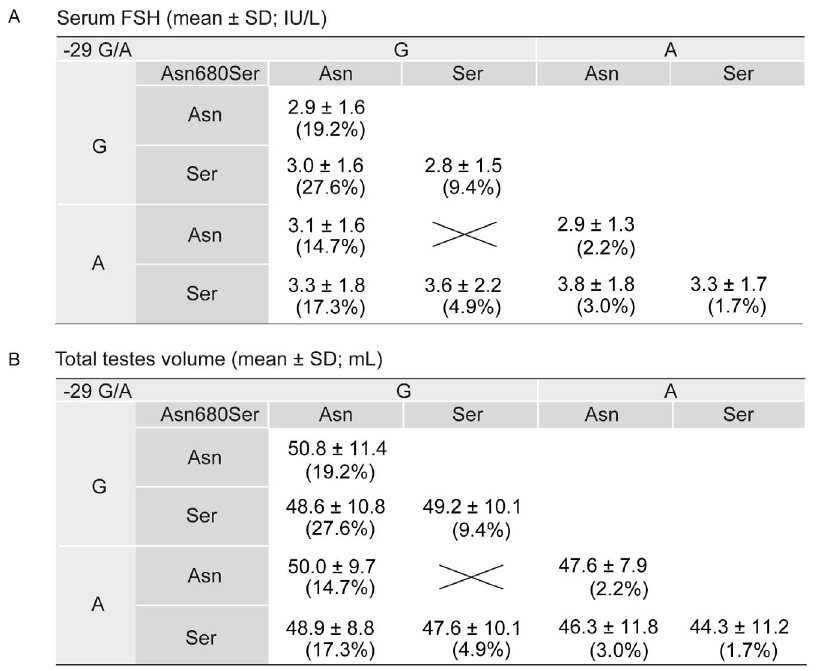
Figure 2. Effect of the carrier status of FSHR -29G/A and Asn680Ser genotype combinations on reproductive parameters. Effect of the FSHR -29G/A (rs1394205) and FSHR Asn680Ser (c.2039A . G, rs6166) genotype combinations on ( A ) serum FSH level (IU/L; mean 6 SD) and ( B ) total testes volume (mL; mean 6 SD) among the Baltic male cohort sample (n=982). The -29G/A and Asn680Ser variants form nine possible FSHR genotype combinations: GG-AsnSer (n=271), GG-AsnAsn (n=189), AG-AsnSer (n=170), AG-AsnAsn (n=144), GG-SerSer (n=92), AG-SerSer (n=48), AA-AsnSer (n=29), AA-AsnAsn (n=22), AA-SerSer (n=17). The prevalence of each genotype combination (%) is shown in brackets.